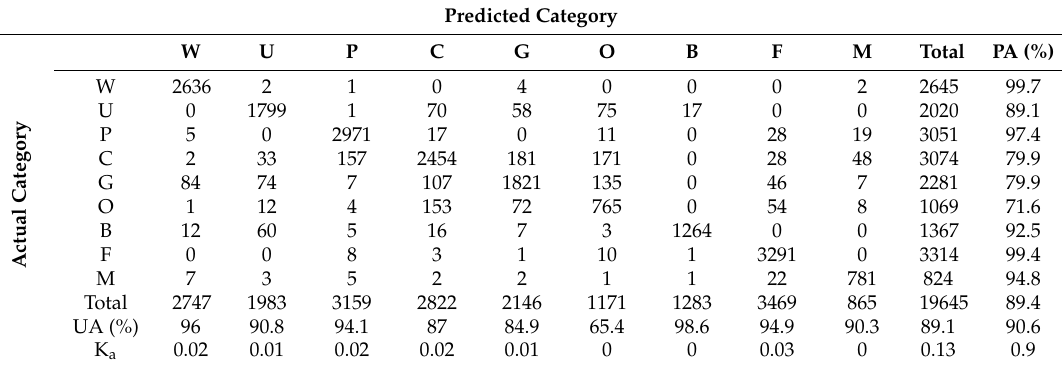
Table 5. Accuracy assessment of the 2017 land cover maps over Central Vietnam, using a confusion matrix.